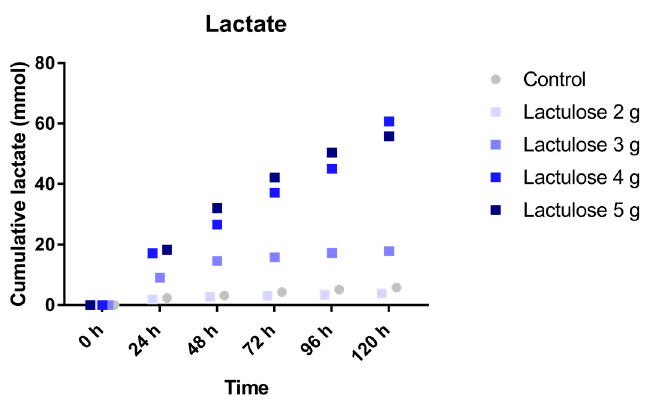
Figure 4. Cumulative lactate production over time during the 120 h test period in TIM-2 runs (mean of n = 2 (Lactulose dosages) or n = 4 (control)). All data points shown at the proximity of the individual time points indicated at the X -axis belong to these specific time points.